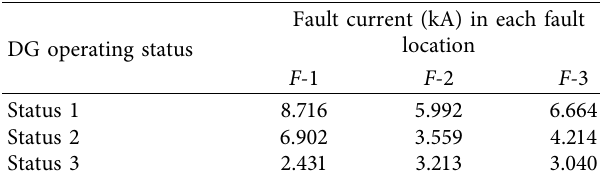
Table 4: Fault current magnitude in grid-connected microgrid. Table 5: Fault current magnitude in islanded